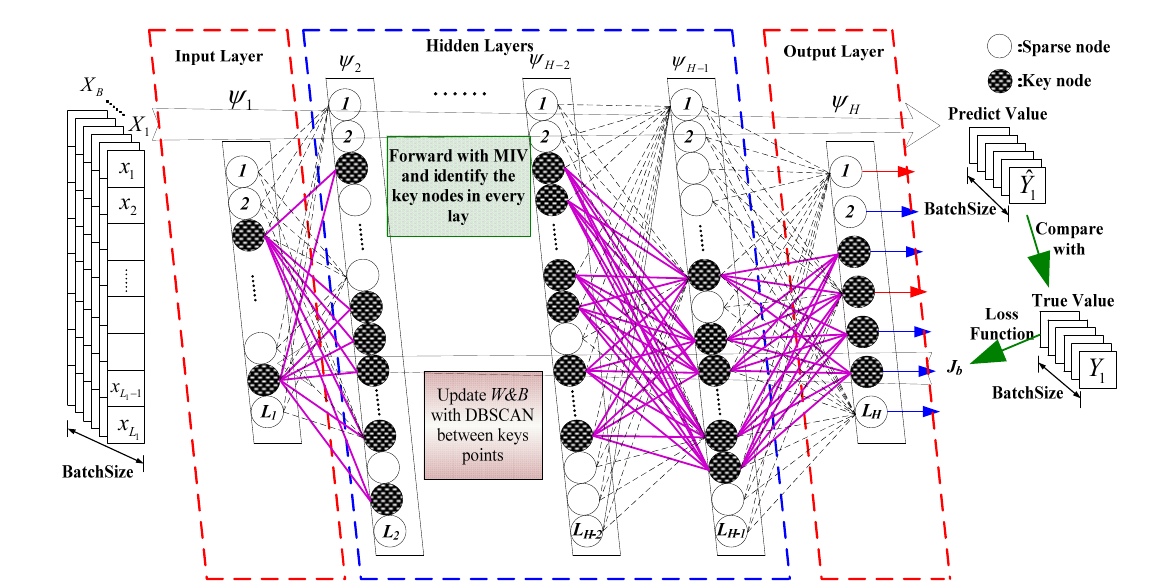
Figure 5. SDGD algorithm flow chart. The input data for each batch in Figure 5 are X 1 , X 2 ,. . ., X B and X The network consists of three pieces: the input layer, the hidden layers, and the output layer. The white neurons in the network layer indicate less important nodes after MIV filtering. The black neurons indicate key nodes. The neuronal connections between all key nodes are indicated by the purple connecting lines, which are updated with the SDGD algorithm during the gradient update. The rest of the connection lines are connected by dashed lines. The red arrows in the output layer indicate that the output value is positive at that location, while blue is negative. The input data are first propagated forward, indicated by the large green arrow, to give the predicted output ˆ Y . The loss value, J , is calculated after a comparison with the real output. The network weights are then updated by back- propagating through the large red arrow. W & B in the figure indicates the network